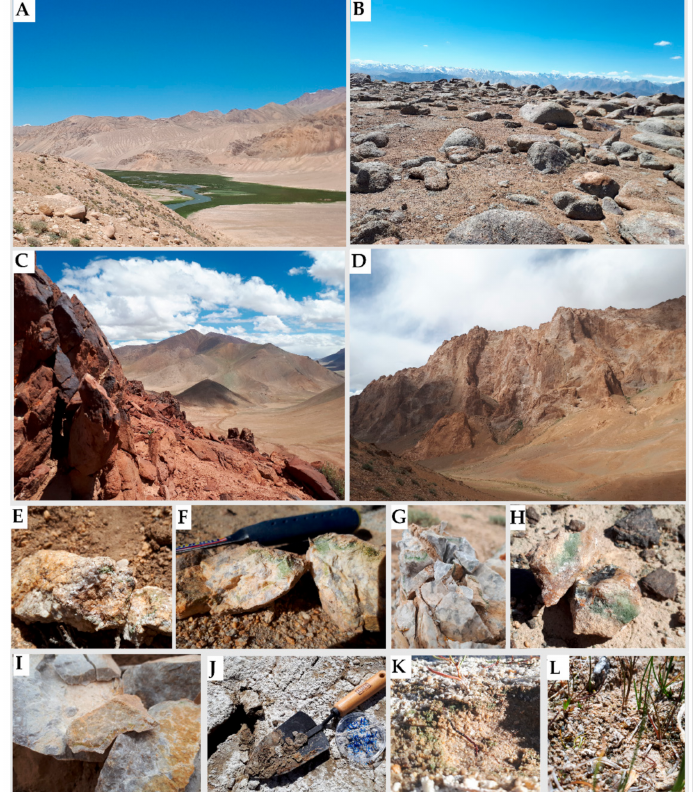
Figure 1. Field sites and investigated types of samples. ( A ) The field area near Bulunkul Lake. ( B ) Sampling site near Karakul. ( C , D ) The view from the mountainside near Rangkul. ( E , F ) Peg- matites, ( G ) limestone, ( H ) quartzite and ( I ) calcites with endolithic colonization and biological soil crusts collected from ( J ) Rangkul, ( K ) Bulunkul and ( L )